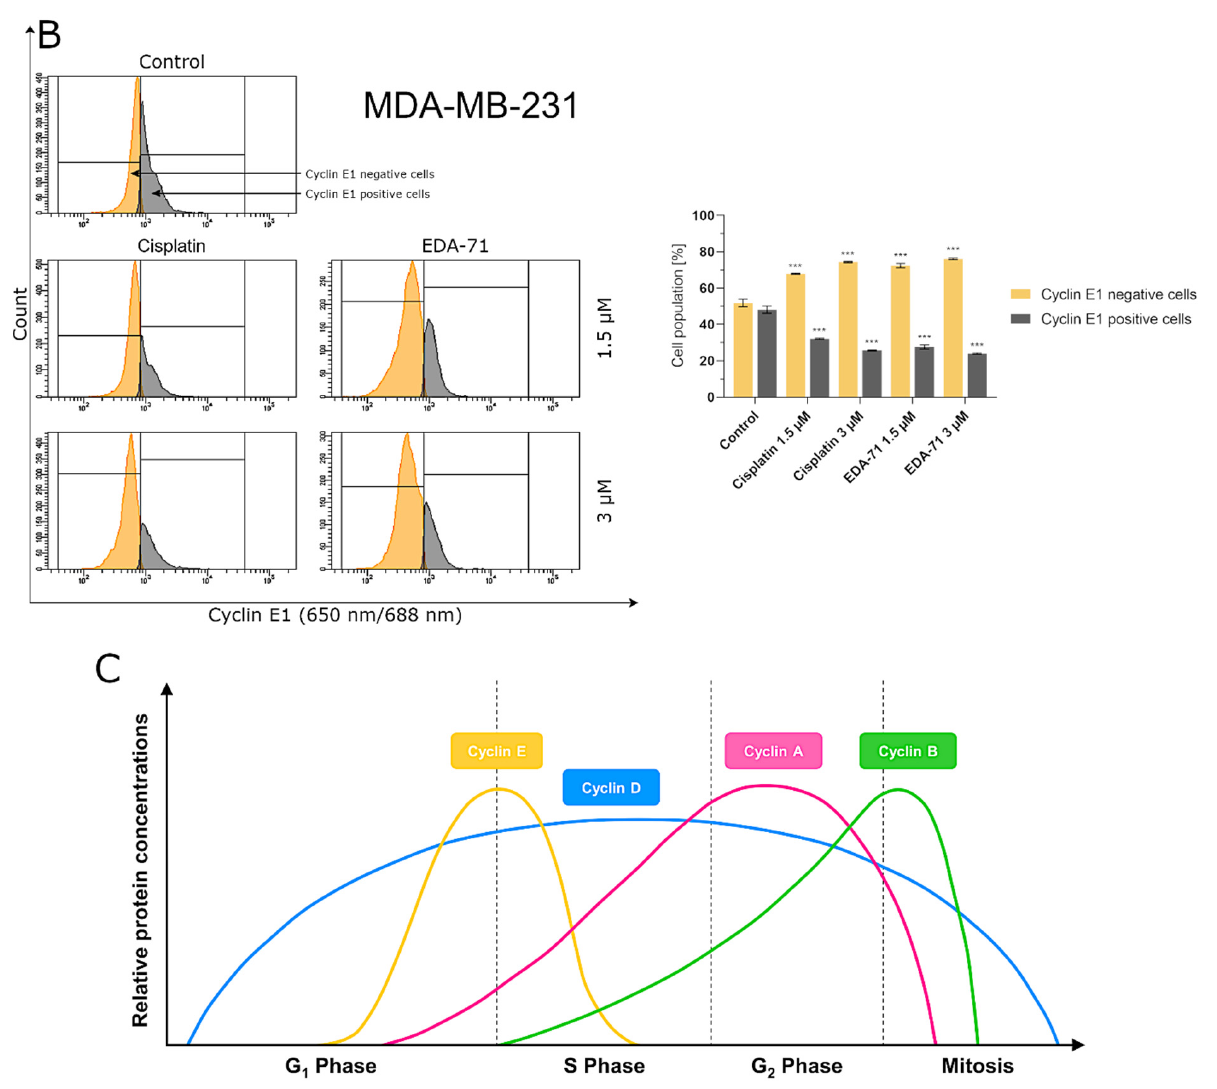
Figure 14. Cytometric analysis of cyclin E1 activity in MCF-7 ( A ) and MDA-MB-231 ( B ) breast cancer cells after 24 h incubation with EDA-71 and cisplatin (1.5 and 3 µM). Results are presented as mean values ± SD obtained from three independent experiments ( n = 3) conducted in triplicate. Statistical differences between the experimental (treated cells) and control (untreated cells) groups were determined using one-way ANOVA followed by Dunnett’s test. *** p < 0.001 vs. control group. ( C ) illustrates changes in the relative concentrations of individual cyclins depending on the phase of the cell cycle (modified from